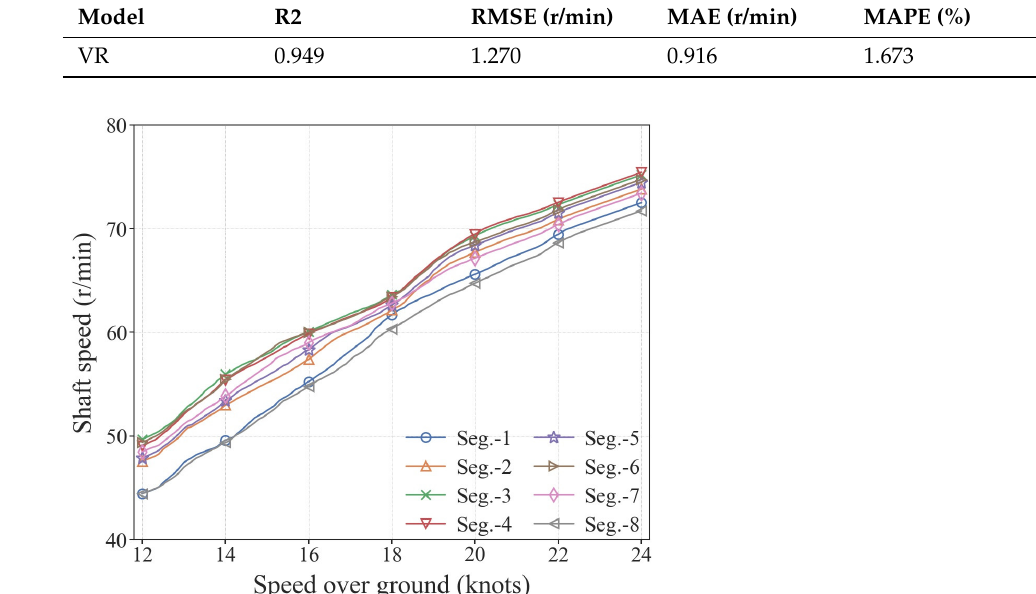
8 of 24 Figure 2. Trend reliability differences before and after fuel consumption model integration on test segments. ( a ) ET model. ( b ) PR model. ( c ) VR model. It can be seen from Table 2 that the prediction accuracy of the VR model is slightly weaker than that of the ET model but significantly stronger than that of the PR model, indicating that the VR model still has relatively high prediction accuracy. In terms of pre- diction reliability, it can be seen from Figure 2 that the VR model has a more reasonable and smooth speed-main engine fuel consumption variation trend than the ET model, and there is no obvious breakpoint phenomenon. The VR model combines the high accuracy advantages of the ET model and the strong reliability advantages of the PR model, laying a solid and reliable model foundation for the subsequent ship speed optimization. In addition, in actual sailing, the ship usually changes the ship speed by directly ad- justing the speed of the main engine (shaft). Therefore, to obtain the optimal shaft speed corresponding to the optimal ship speed, the shaft speed prediction VR model is con- structed in the same integrated way as the main engine fuel consumption prediction model, with the input features of the two models consistent. Moreover, considering the